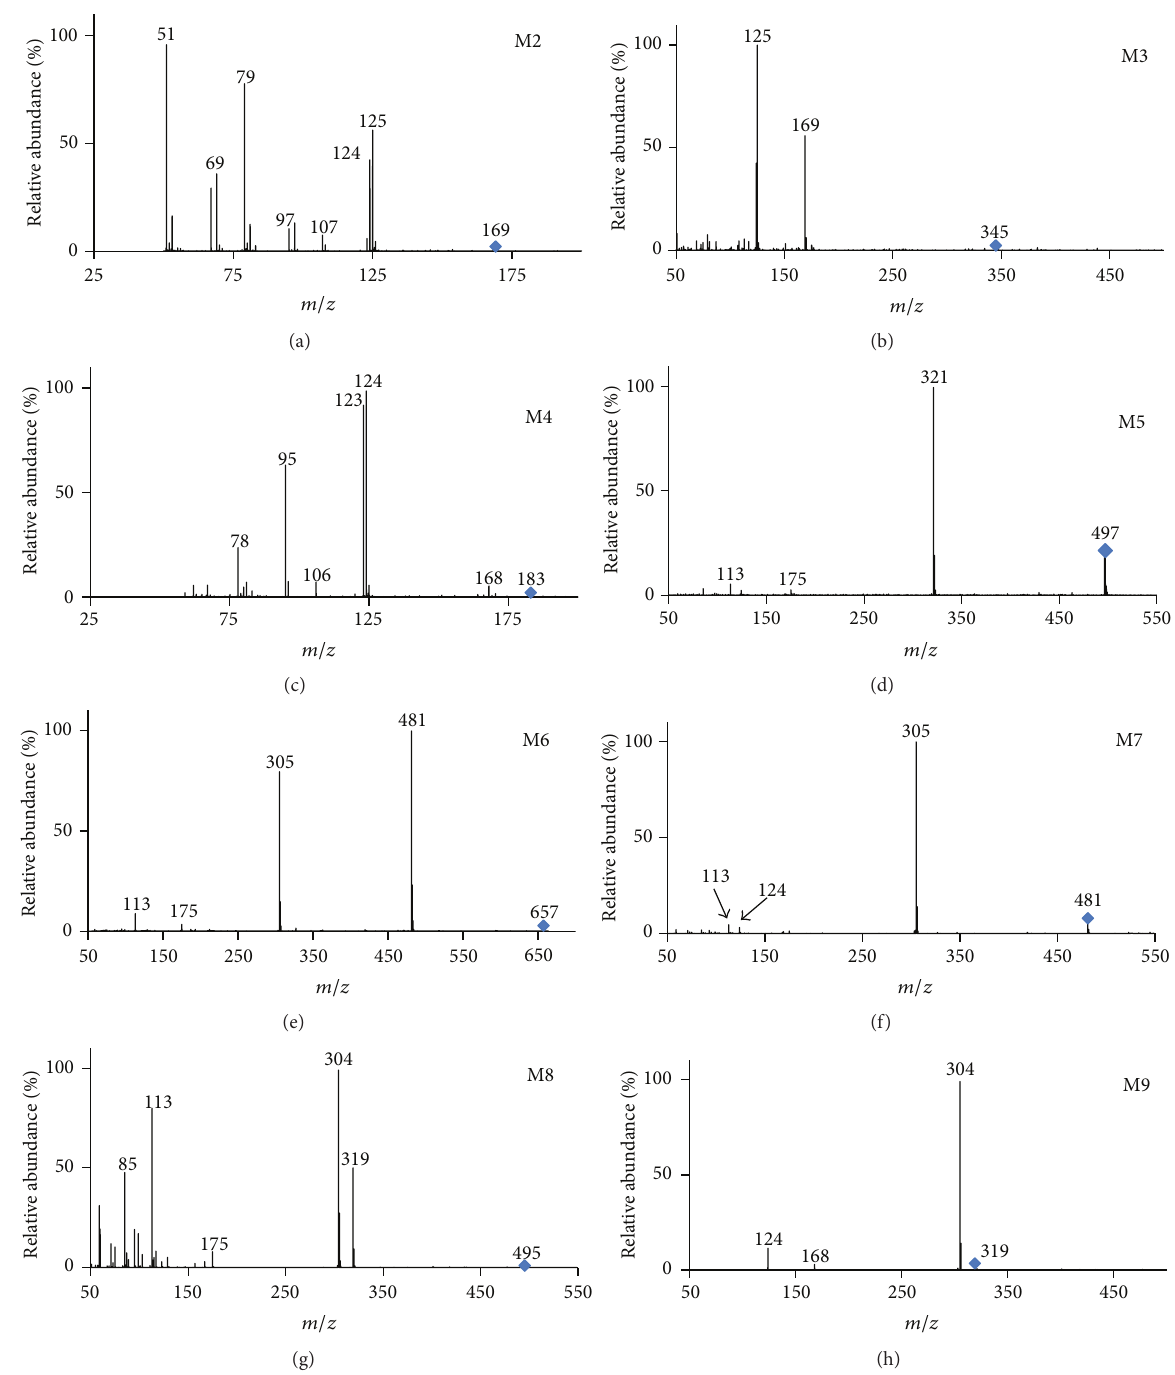
Figure 6: Representative MS/MS spectra of the in vivo metabolites M2 to M9 of BG in